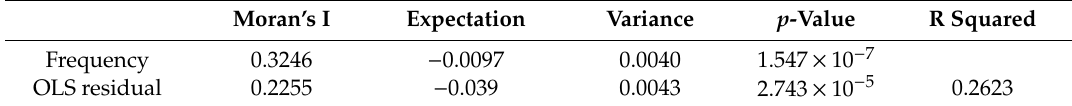
Table 2. Results of the spatial autocorrelation test.